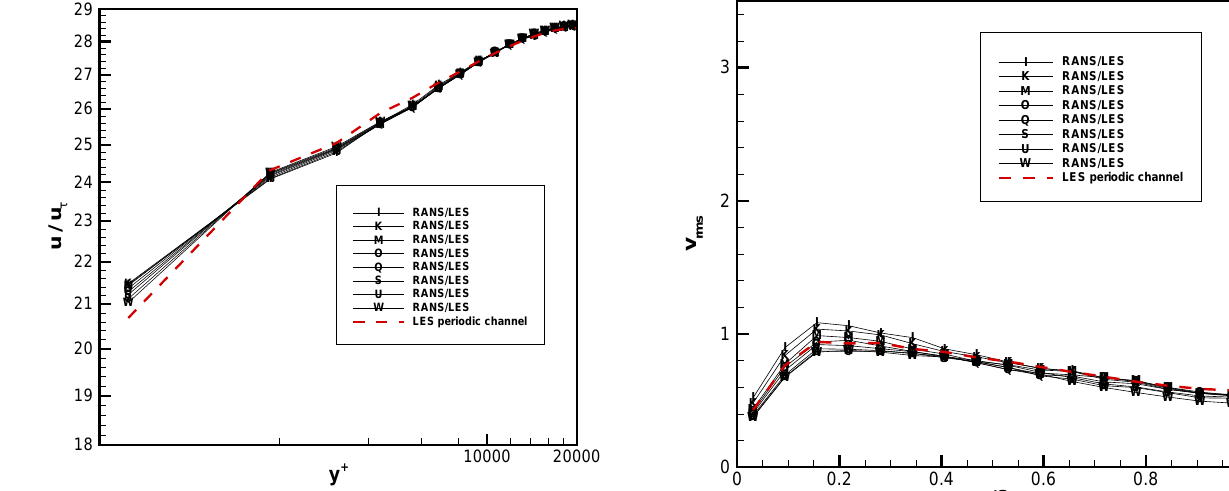
Fig. 5. Comparison of the mean velocity profile for nested channel flow simulation with body-force. Red dashed line: reference results from the periodic channel simulation; black lines: mean velocity profile at different sections of the channel with the buffer region.